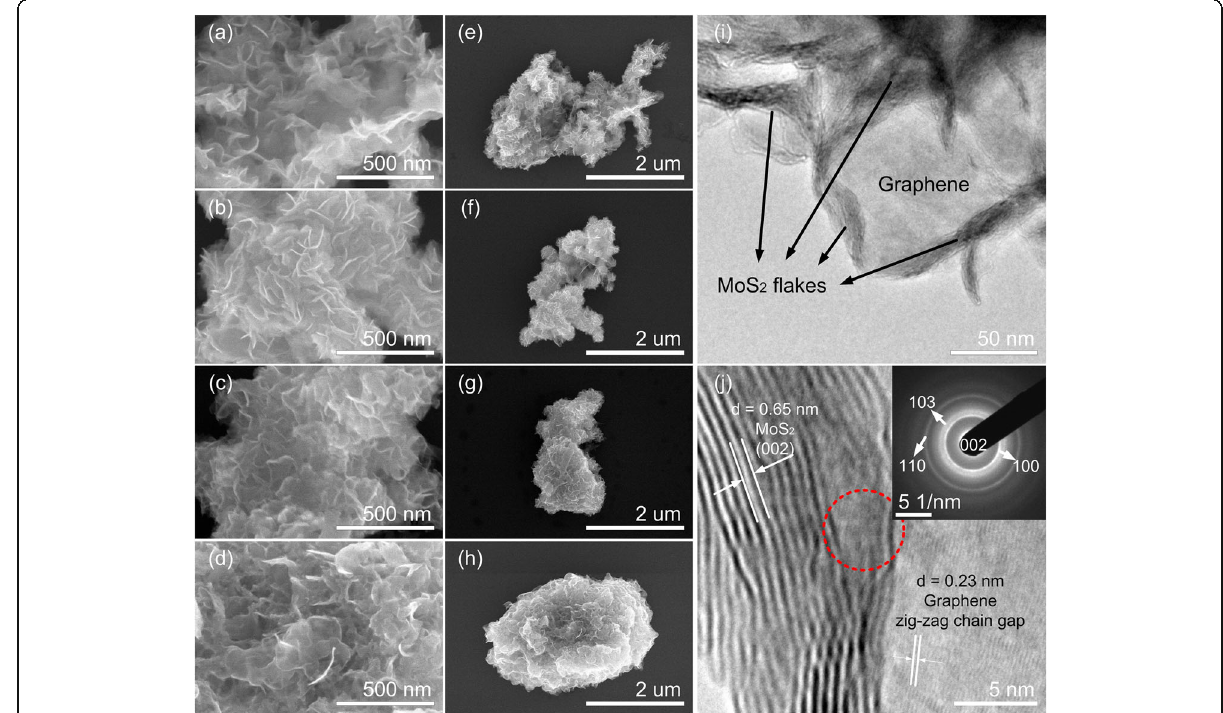
Fig. 1 Morphology of MoS 2/ graphene hybrids. SEM images of MoS 2/ graphene hybrids at 150 °C ( a , e ), 180 °C ( b , f ), 210 °C ( c , g ), 240 °C ( d , h ), and TEM and HRTEM images of the MoS 2 /graphene hybrid at 180 °C ( i , j ). The inset of ( j ) is the corresponding SAED pattern marked by the dashed circle. Lattice information is marked in ( j